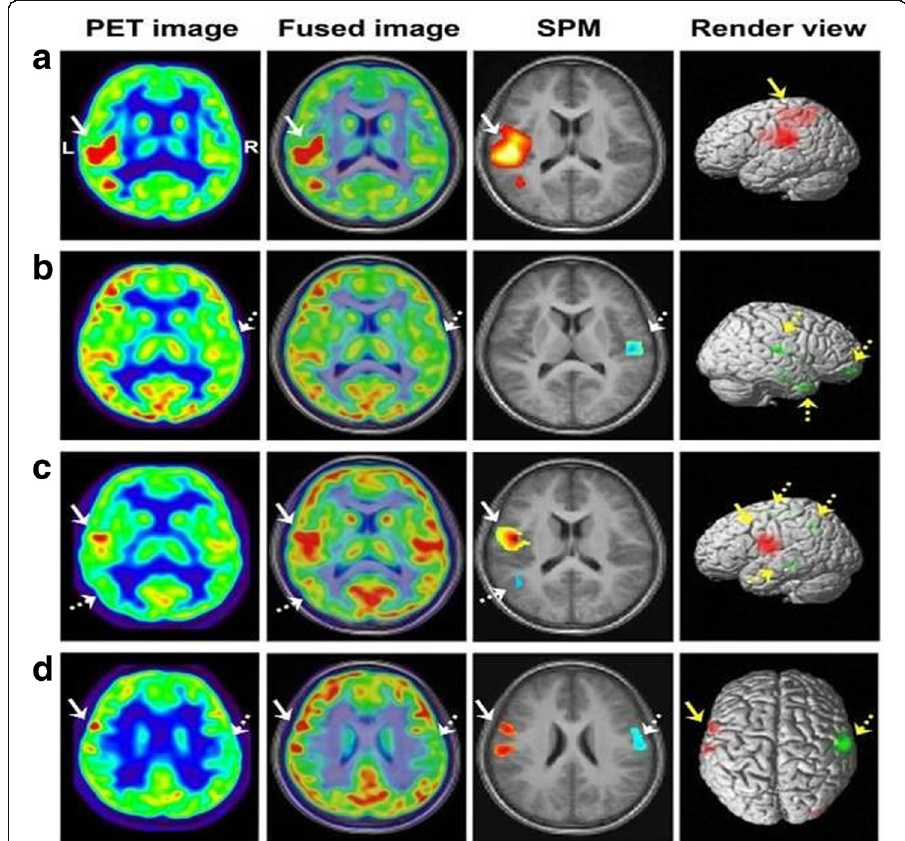
Fig. 11 Comparison between visual and SPM analysis of 18F-FDG PET images. ( a ) Hypermetabolism in bilateral frontal lobes (solid arrow) was detected by both visual and SPM analysis. ( b ) Hypometabolism in left temporal lobe (solid arrow) was detected by both visual and SPM analysis. ( c ) Hypometabolism was found in left rolandic area (dashed arrow) by visual assessment, and hypermetabolic region was further identified in right rolandic area (solid arrow) by SPM analysis. ( d ) Hypometabolic region undetected by visual assessment was identified in left mesial temporal lobe (solid arrow) by SPM analysis. (This research was originally published in Y. Zhu et al., “ Glucose Metabolic Profile by Visual Assessment Combined with Statistical Parametric Mapping Analysis in Pediatric Patients with Epilepsy, (Zhu et al. 2017) ” J. Nucl.